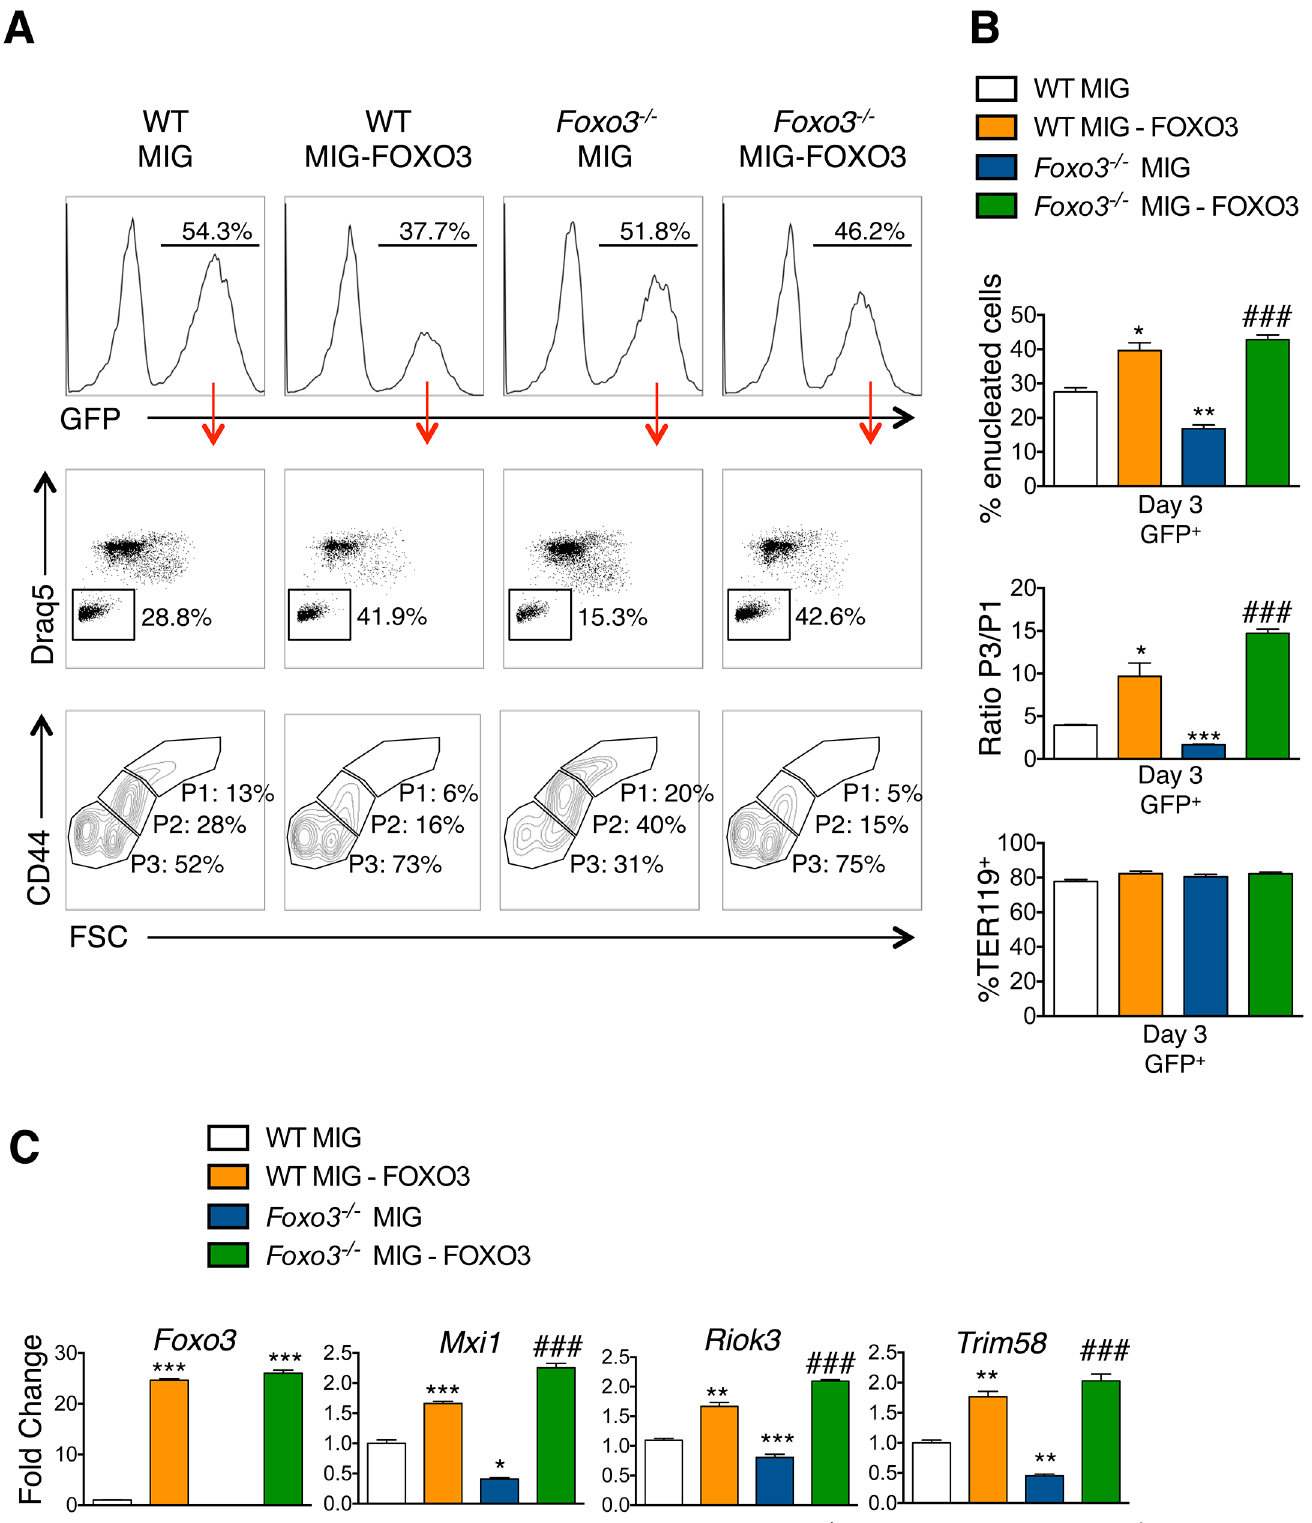
Fig 7. Ectopic expression of FOXO3 rescues terminal maturation and enucleation in Foxo3 -/- erythroblasts. (A) WT and Foxo3 -/- bone marrow erythroid progenitors were expanded and transduced with either the MIG vector overexpressing FOXO3 (MIG-FOXO3) or the MIG vector alone, transferred to